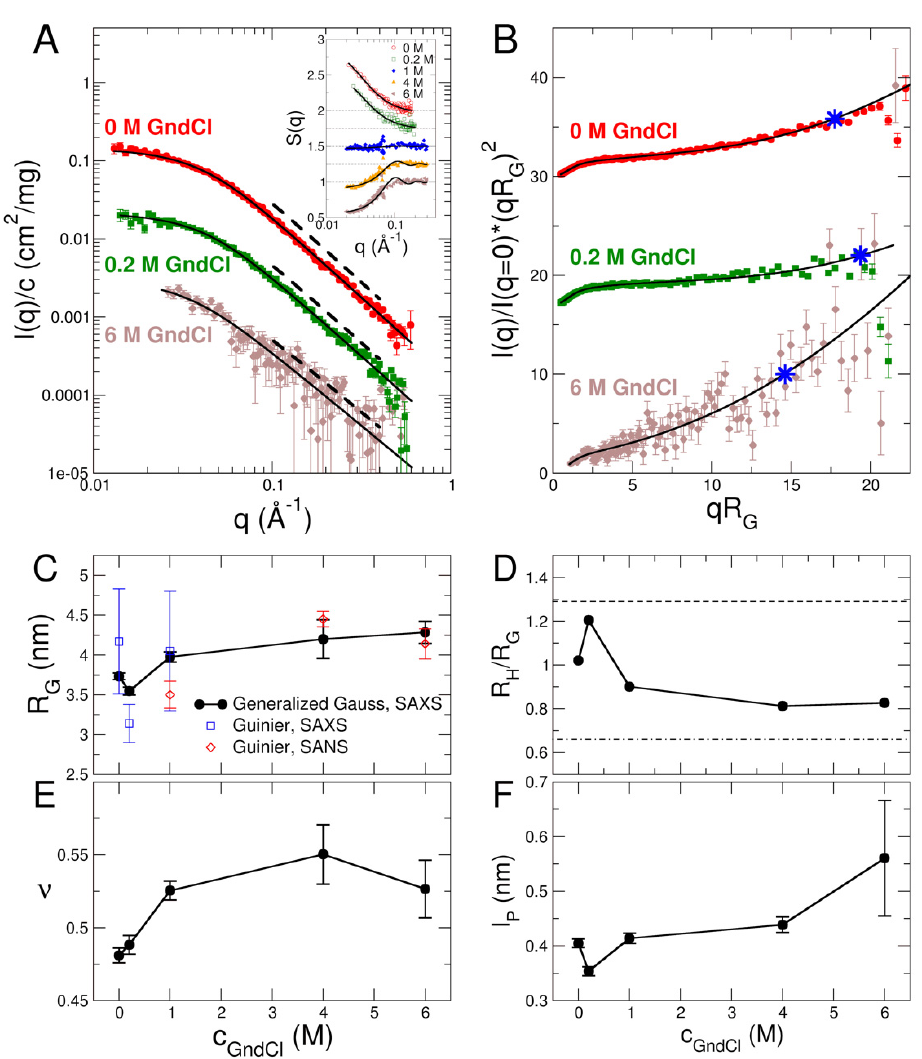
Figure 2. Structural information obtained with SAXS. ( A ) Form factors of native MBP in 0 M GndCl, the structurally collapsed state in 0.2 M GndCl, and the fully denatured and expanded state in 6 M GndCl. Symbols represent experimental SAXS data, solid black lines are fits with generalized Gauss functions, dashed lines indicate power law scaling behavior of the data. The inset in panel A shows the structure factors of the GndCl concentration series (empty symbols: SAXS, filled symbols: SANS data). Structure factors are shifted by an offset of 0.25 for clarity. ( B ) Kratky plots. Symbols indicate experimental SAXS data, solid black lines represent fits with a worm-like chain model. All data start from the origin but are shifted for clarity. Blue asterisk * corresponds to the length scale of the stiff segment given by q * = 1.91/ l p . ( C , E ) Radius of gyration R G and scaling exponent 𝜈 as function of GndCl concentration. Black filled dots are obtained from generalized Gauss fits of SAXS data; empty symbols are R Guinier values obtained from Guinier fits of SAXS and SANS data. ( D ) Influence of GndCl on the compactness of MBP in terms of R H / R G ratio. Dashed lines indicate extreme limits for a globular and random coil-like protein. ( F ) Modulation of persistence length l p of MBP by GndCl.